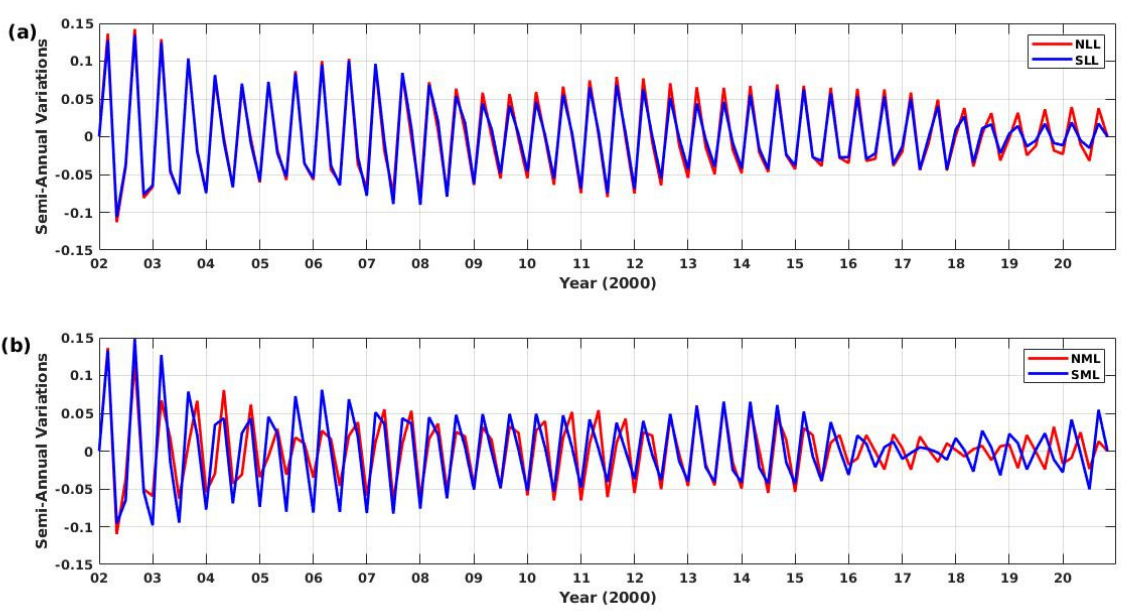
Figure 3. ( a ) Semiannual variations of averaged O/N 2 ratio in both hemispheres for low- latitudes. ( b ) Semiannual variations of mean O/N 2 ratio in both hemispheres for mid-latitudes.